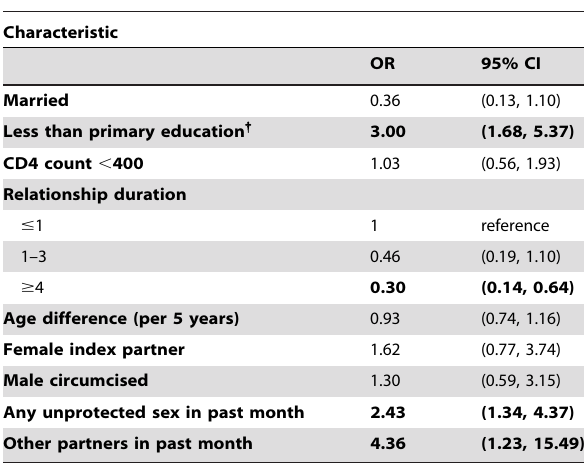
Table 4. Couple characteristics associated with a couple being affected by a current treatable sexually transmitted